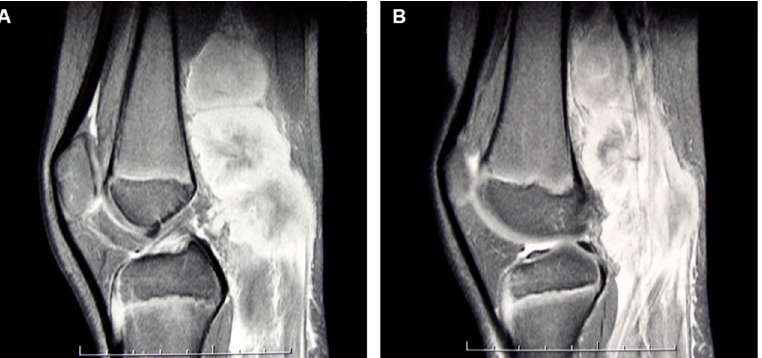
Figure 1. ( A , B ). MRI of the right knee revealed a 5 × 4 × 10 cm multinodular lesion localized in the distal region of the posterior thigh and in the popliteal fossa, isointense to muscle on T1-weighted images and with intermediate signal intensity on T2-weighted images, showing intense and not homogeneous contrast enhancement.